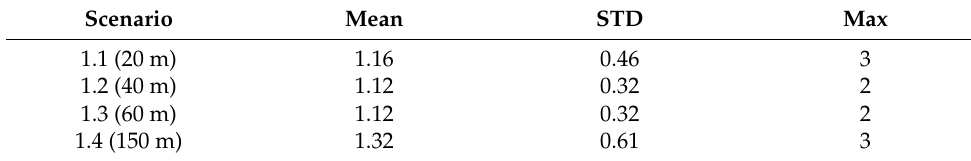
Table 4. Number of activations per Reference